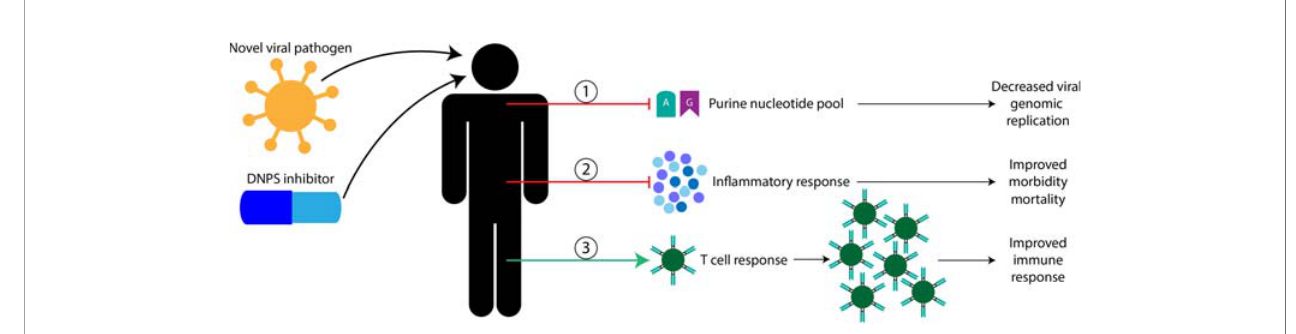
FIGURE 2 | Proposed bene fi ts of targeting host DNPS metabolism for novel viral pathogen infection. Here, I propose that host DNPS targeting therapeutics are likely to have three mechanisms of bene fi t, in no particular order. 1, DNPS inhibitors are likely to reduce purine nucleotide pools used to replicate the viral genome resulting in less viral proliferation. 2, DNPS inhibitors are likely to temper in fl ammatory responses reducing morbidity and mortality in severely affected patients. 3, DNPS inhibitors are likely permissive to T cell recognition and clonal expansion allowing natural host clearance of the